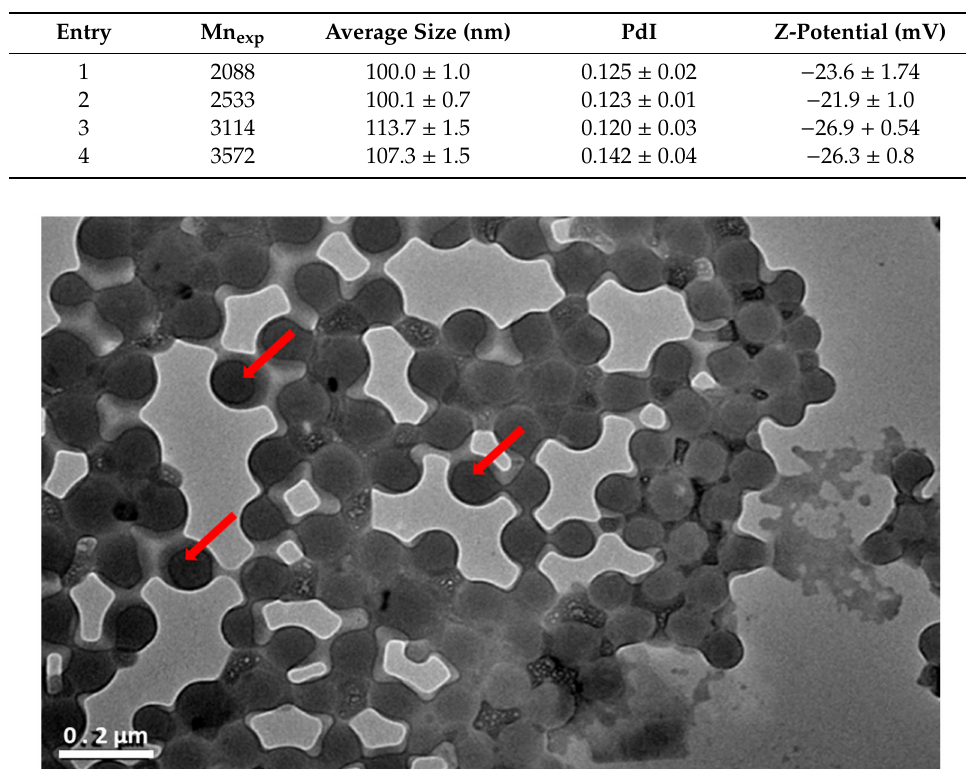
Table 2. Hydrodynamic diameter (nm), polydispersity index (PdI) and Z-potential of CHO / PA NPs.